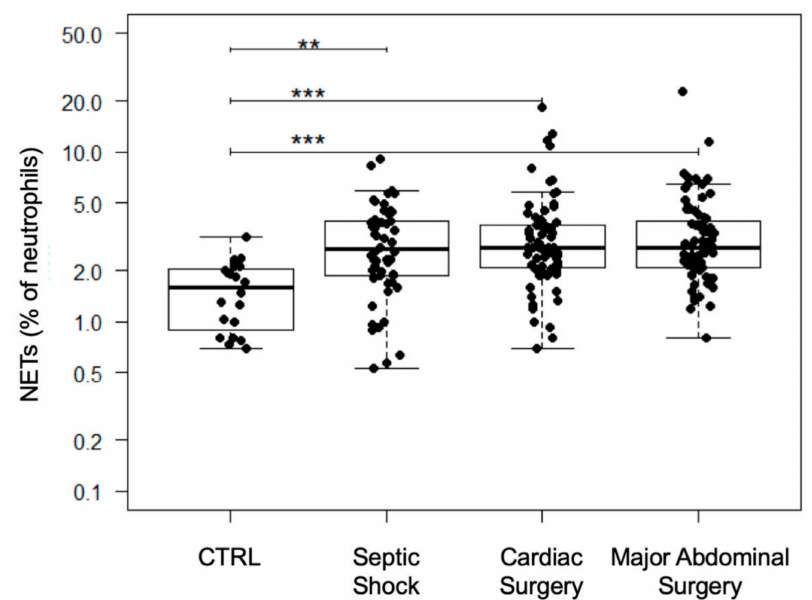
Figure 2. Results of the NET quantification of the study groups. With the exception of preoperative values, all time points per group were summarized. Results are shown in boxplot diagrams. Asterisks display the degree of statistical significance: **: p < 0.01; ***: p < 0.001. Abbreviations: NETs: Neutrophil Extracellular Traps.